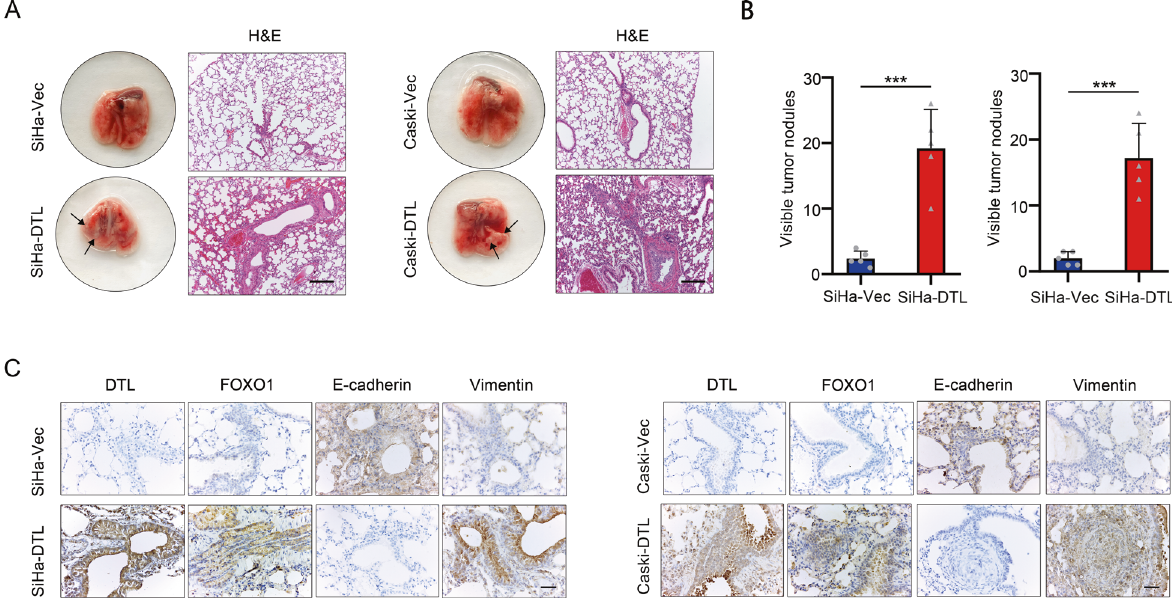
Fig. 6 DTL enhanced the metastatic potential of tumor cells in vivo. A H&E staining and representative images of lung metastatic nodules in a mouse model (magni fi cation, ×100). B Quanti fi ed data of lung metastatic nodules. C Sections of lung metastatic nodules were subjected to IHC staining. Error bars indicate the mean ± SD of three independent experiments (magni fi cation, ×400). Student ’ s t -test; * P < 0.05, ** P < 0.01, *** P <